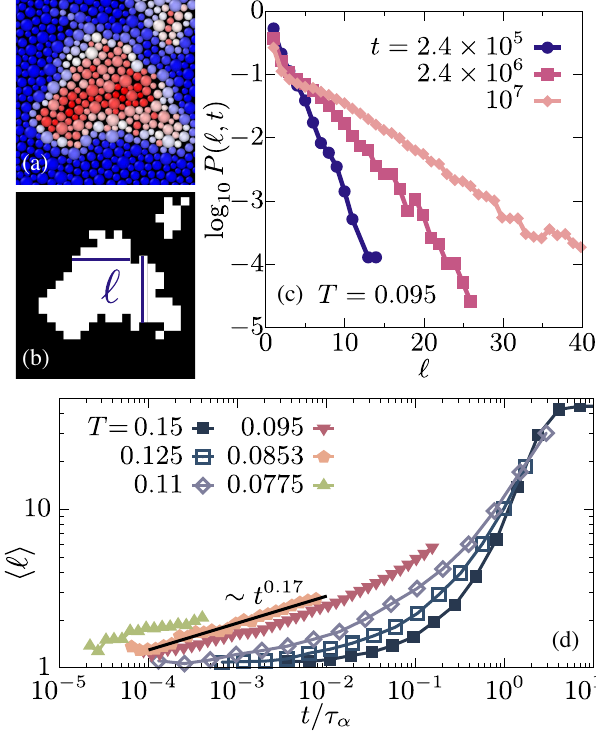
FIG. 18. Slow coarsening of relaxed domains measured by chord length distributions in 2D. (a) Snapshots of a portion of the two-dimensional liquid with a mobility field at T ¼ 0 . 095 (color code from Fig. 4). (b) Discretized version of the mobility field used to measure the length l of chords drawn vertically and horizontally which intersect relaxed domains (white). (c) Chord length distribution P ð l ; t Þ at T ¼ 0 . 095 and increasing times. (d) Growth of the average chord length h l i with time. A slow algebraic growth develops at early times and low